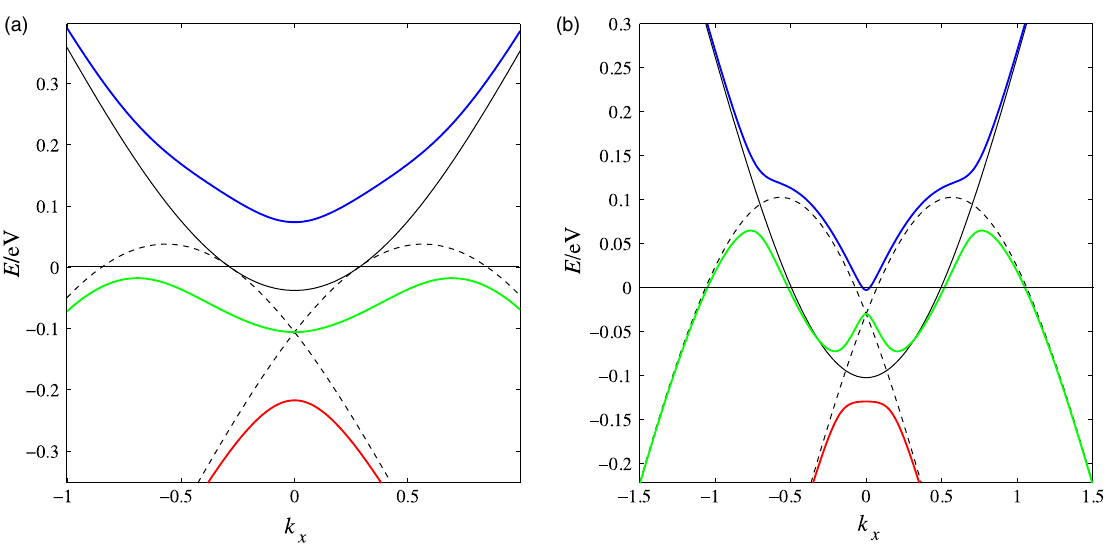
FIG. 2. Plot of the energy bands and the bare dispersion ε k - μ versus k x for (a) k y ¼ π and (b) k y ¼ π − 1 . 0 , using parameters appropriate for Bi-2201 [12]. The dashed lines show − ð ε k and creates an energy gap for k y ¼ π . The gap vanishes for k y ¼ π − 1 . 0 , creating a Fermi